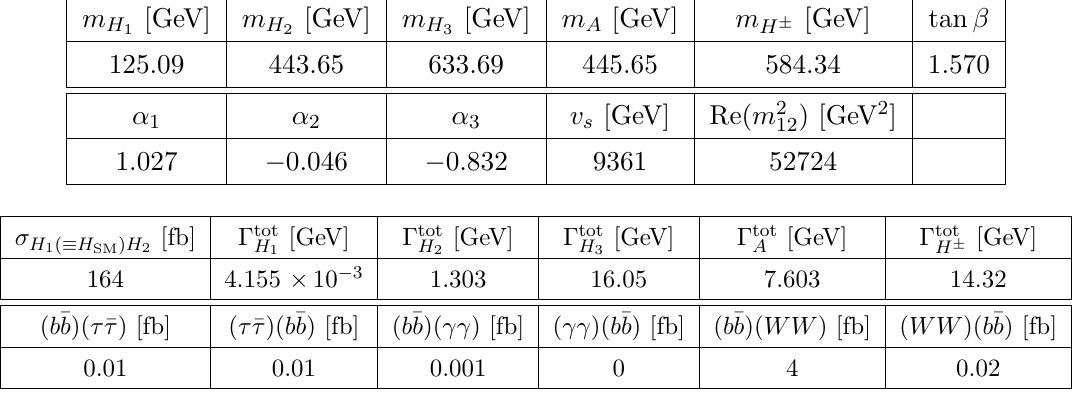
Table 29 . BP14 Upper: N2HDM-I input parameters. Lower: further information on this point.